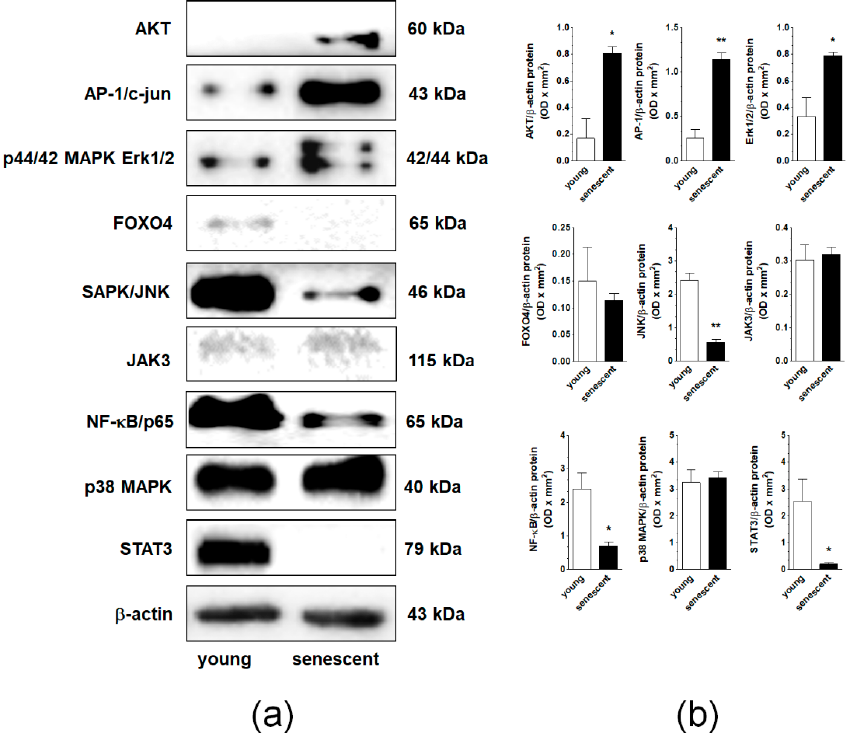
Figure 5. Changes in the expression of signaling molecules during senescence of pEOCs determined using immunoblotting. ( a ) Samples corresponding to 1 × 10 4 (AKT, AP-1, ERK1/2, JNK, NF- κ B, p38 MAPK, STAT3), 4 × 10 4 (FOXO4, JAK3), and 5 × 10 4 ( β -actin) cells were subjected to SDS–PAGE to eliminate the risk of incorrect results due to senescence-associated cell hypertrophy and related dif- ferences in protein content between young and senescent cells. ( b ) Densitometric analysis of bands corresponding to young and senescent cells. Results are based on five to six independent experi- ments using pEOCs obtained from different patients. Results are expressed as mean ± SEM. * p < 0.05; ** p < 0.01 vs. early-passage cells.